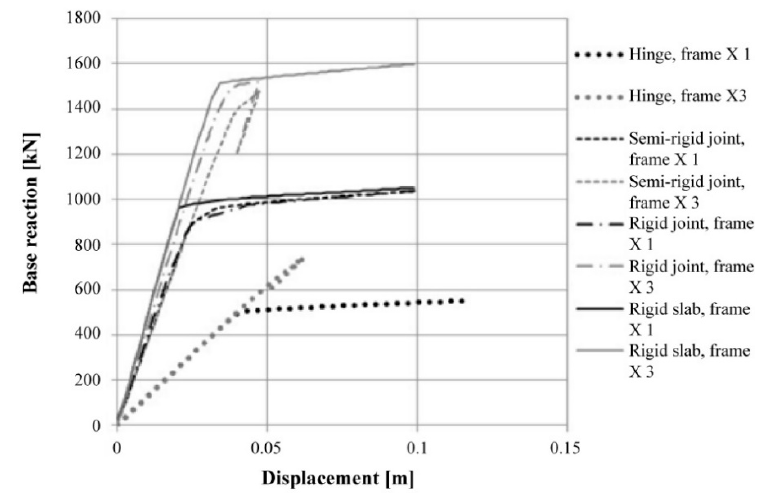
Figure 13. Non-linear static curves in the transverse ( X ) direction.